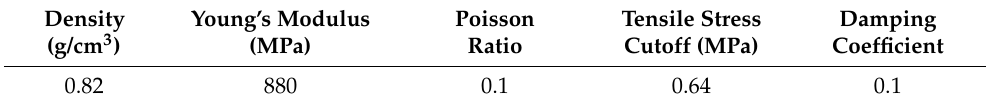
Table 6. Material parameters of foamed concrete.